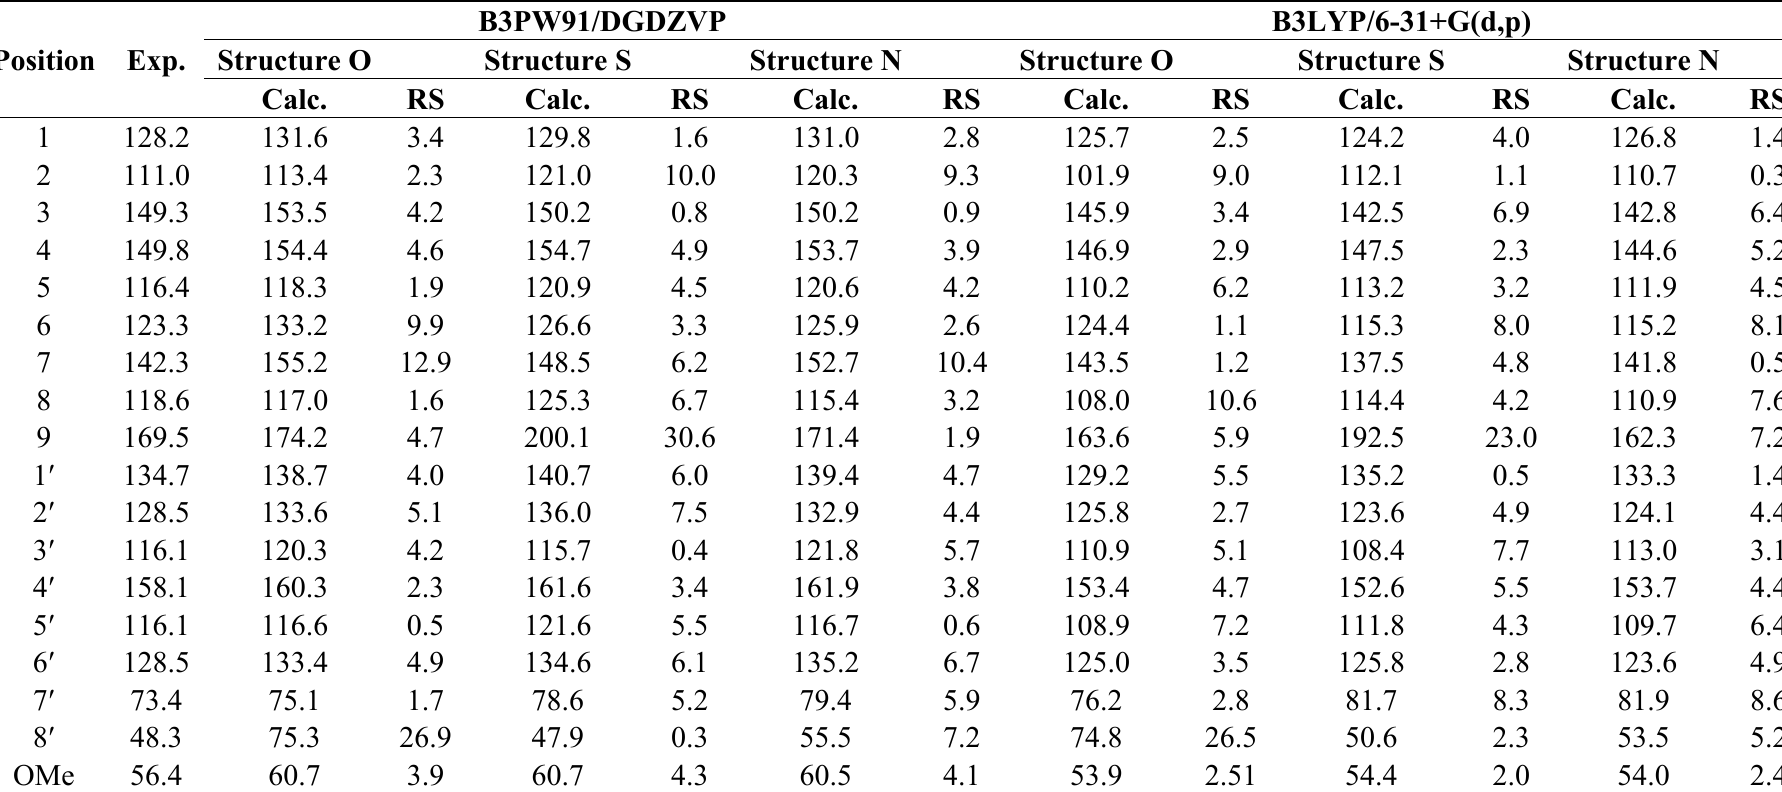
Table 1. Experimental 13 C nuclear magnetic resonance (NMR) data (Exp.), calculated 13 C NMR data (Calc.) with B3PW91/DGDZVP and residue (RS) in ppm for the O , S and N